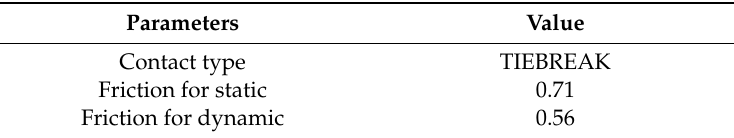
Table 6. Parameters for the interface simulation.